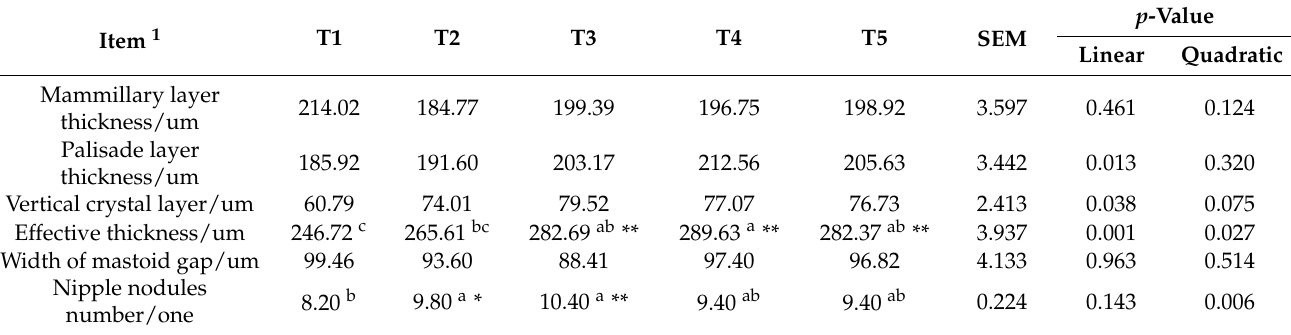
Table 5. Effects of casein phosphopeptide (CPP) on ultrastructure of eggshell of laying hens.